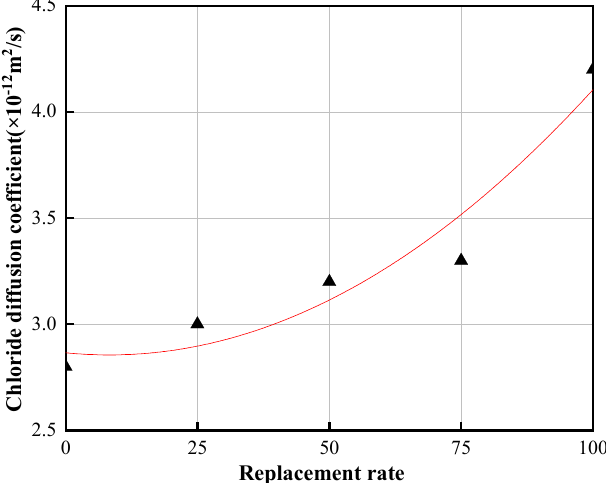
Figure 9. Fitted graph of chloride diffusion coefficient of MS3 series concrete.